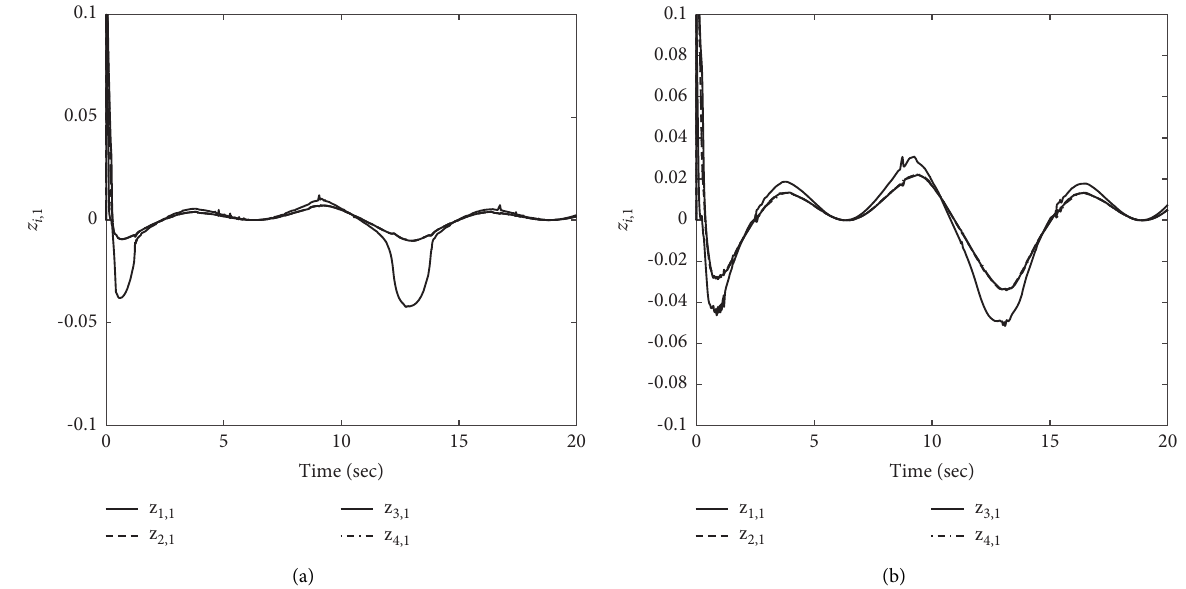
Figure 3: (a) Tracking errors z